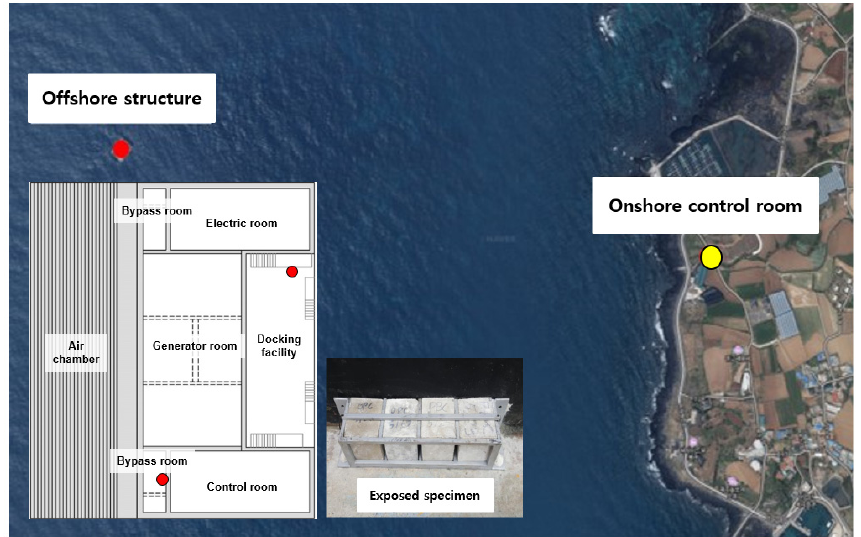
Figure 5. Location of offshore structure (OWC) and onshore control room.